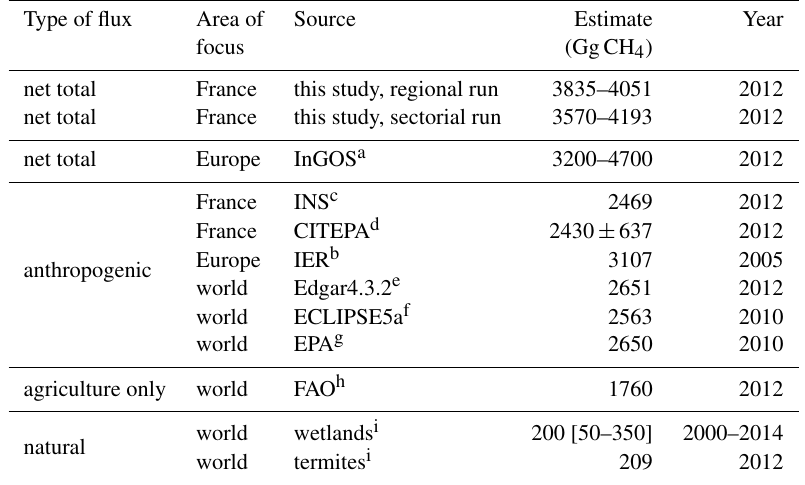
Table 5. Estimates of yearly total CH 4 emissions (in GgCH 4 ) in France: top-down for our study and the European project InGOS (result from 6 different models), bottom-up for anthropogenic inventories, 11 biogeochemical models for natural fluxes from wetlands and 1 model for emissions by termites. Some methods do not provide